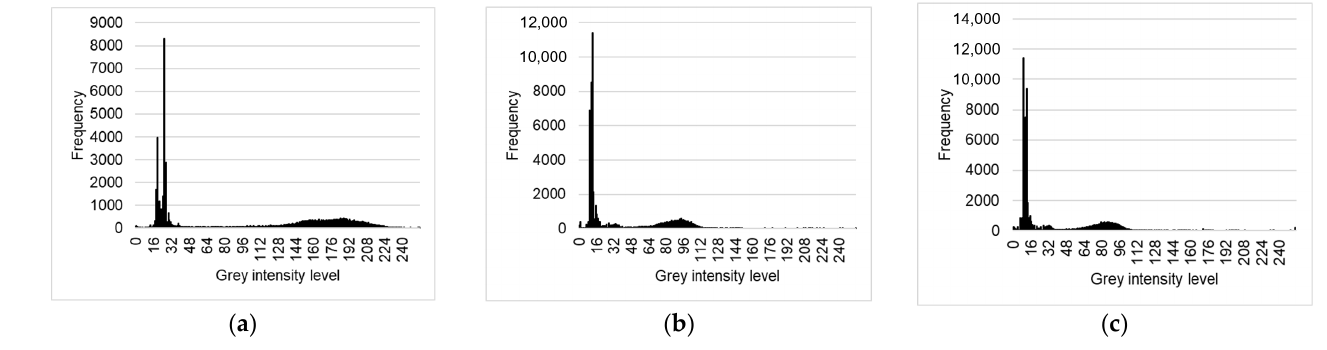
Figure 8. Greyscale histograms for M1 ( a ), M2 ( b ) and M3 ( c ).